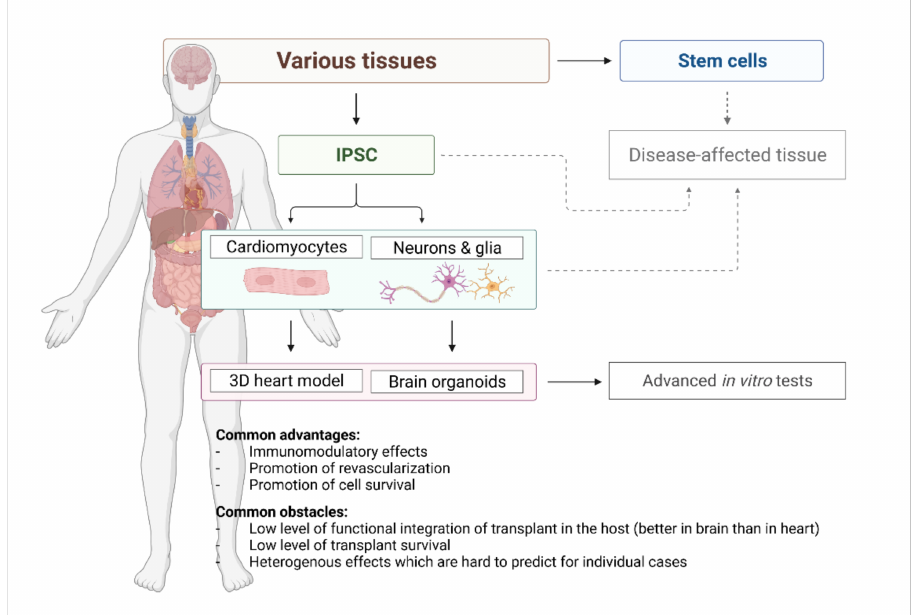
Figure 2. Current options offered by stem cell-based technology for regenerative cardiology and